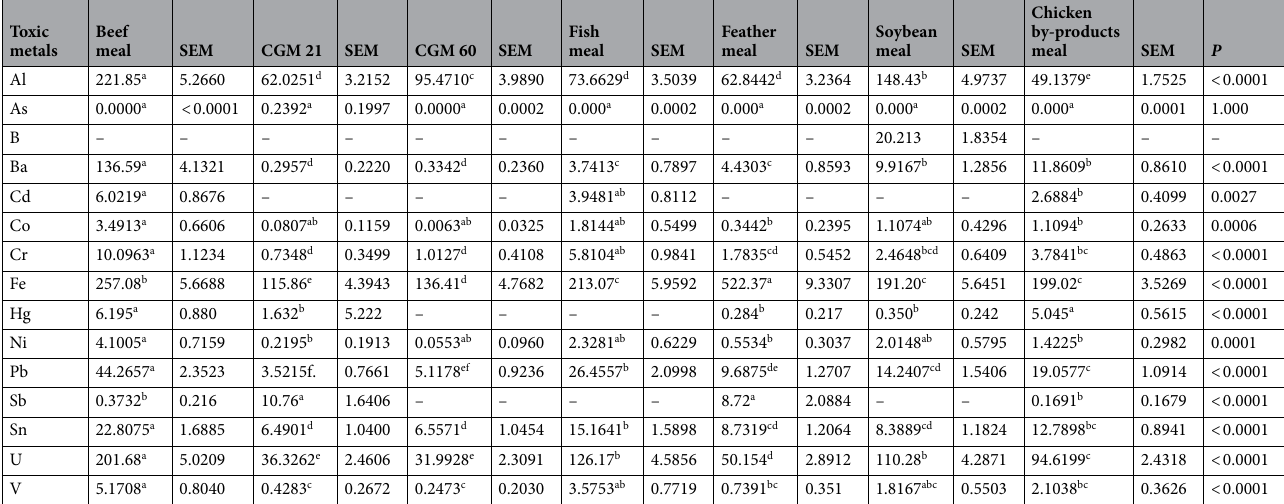
Table 12. Detected toxic metals concentrations (mg/kg) in the evaluated protein sources. Al aluminum, As arsenic, B boron, Ba barium, Cd cadmium, Co cobalt, Cr chromium, Cu copper, Fe iron, Hg mercury, Ni nickel, Pb lead, Sb antimony, Sn tin, U uranium, V vanadium, Zn zinc, CGM 21 corn gluten meal 21, CGM 60 corn gluten meal 60, SEM standard error mean, P probability of significance. a,b Means followed by different letters in the lines differed (P < 0.05).